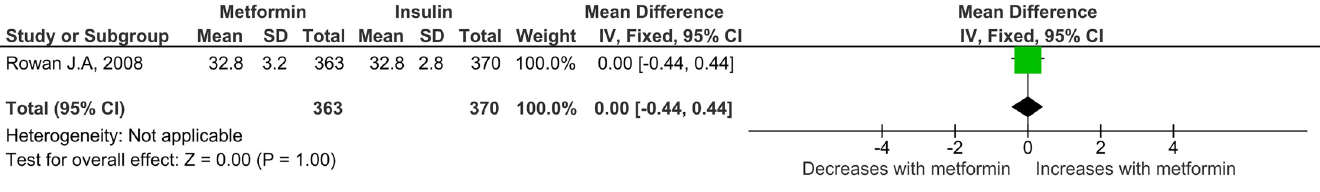
Fig 8. Neonatal abdominal circumference. Expressed as mean difference (fixed effects model) and 95% CI. IV, mean difference.